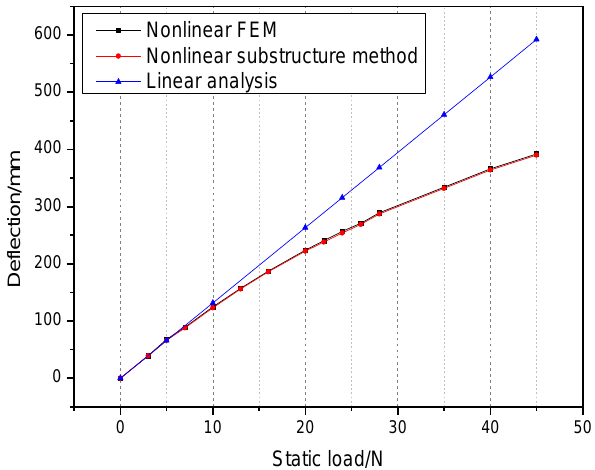
Figure 9. Static response analysis results.